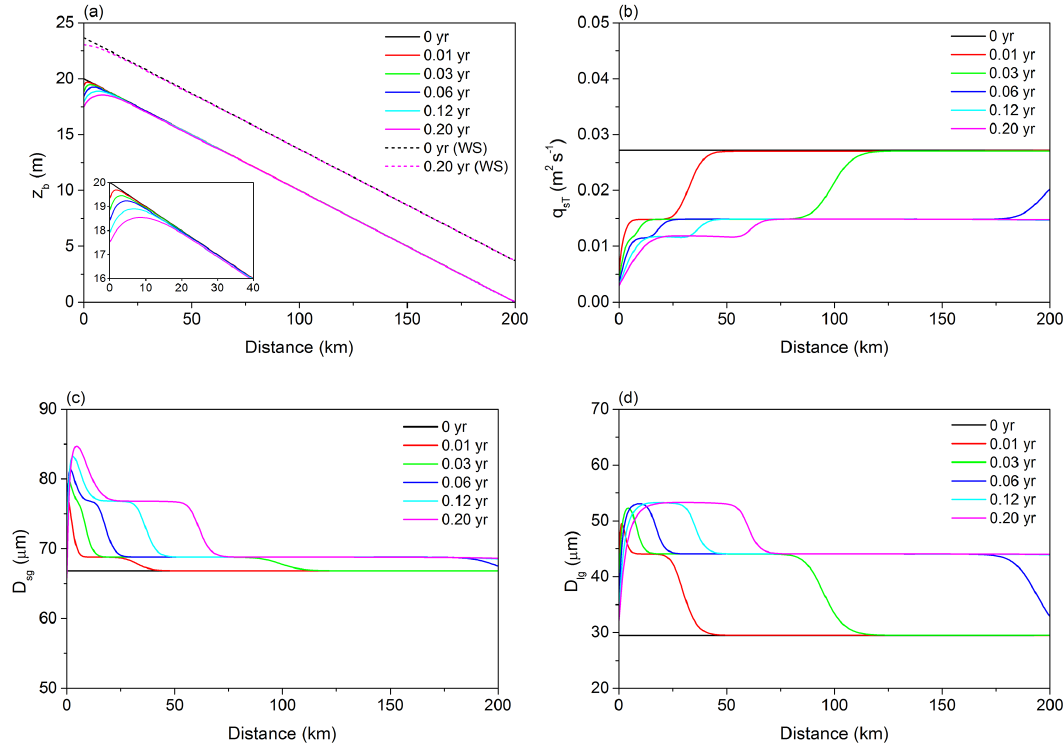
Figure 8. The 0.2-year results for the case of sediment mixtures using the entrainment form of the Exner equation: time variation of (a) bed elevation z b and water surface (WS), (b) total sediment load q sT , (c) surface geometric mean grain size D sg , and (d) geometric mean grain size of sediment load of the LYR in response to the cutoff of sediment supply. Sediment fall velocities v s i are arbitrarily multiplied by a factor of 20 in this run while keeping the grain sizes invariant. The inset shows detailed results near the upstream end.